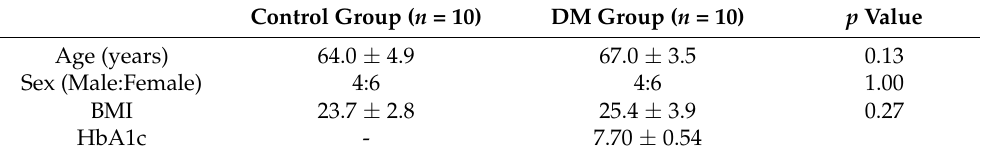
Table 1. Demographics and baseline clinical characteristics of the participants.